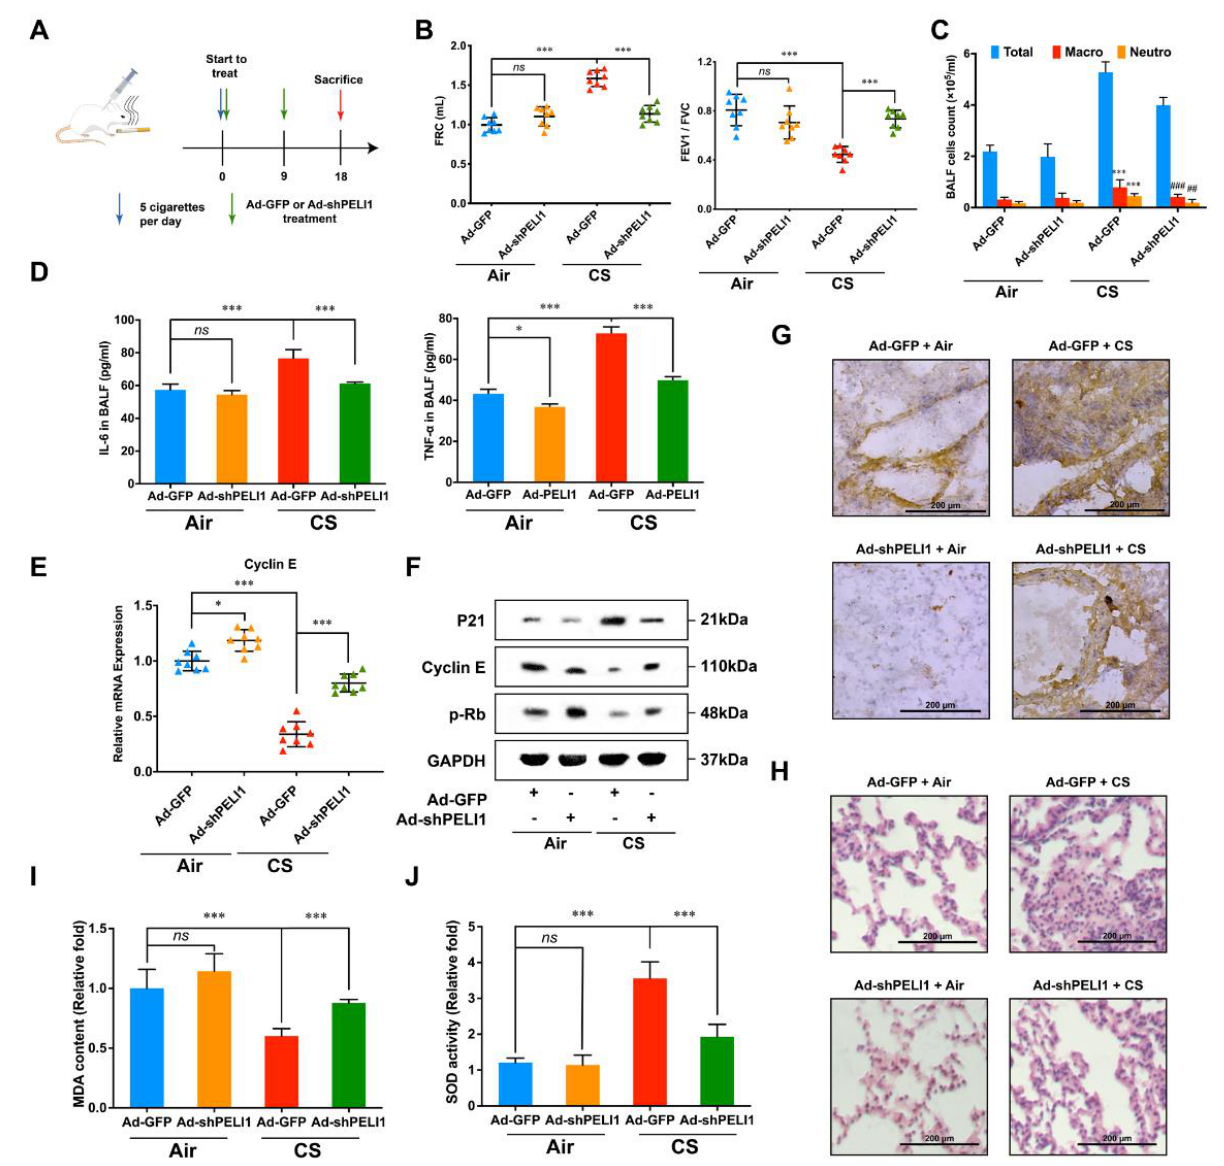
Figure 4. Silencing Pellino-1 inhibited COPD in anti-senescence and anti-inflammation pathways in vivo. ( A ) The strategy for studying the anti-COPD effects of silencing PELI1 in vivo. ( B ) FRC and FEV1/FVC following administration of 10 mg/kg budesonide 1 h before sacrifice. Silencing PELI1 decreased FRC and increased FEV1/FVC caused by CS significantly. Data represent mean ± SEM; *** p < 0.001, ns for not significant. ( C ) White cell counts in BALF showed that silencing PELI1 could decrease the high white cell counts caused by CS. Data represent mean ± SEM; ## p < 0.01, ### p < 0.001 vs. (CS + ad-GFP group), *** p < 0.001 vs. (Air + ad-GFP group). ( D ) ELISA to analyze the protein level of IL-6 and TNF- α in BALF. Silencing PELI1 significantly reduced the high protein levels caused by senescence. Data represent mean ± SEM; * p < 0.05, *** p < 0.001, ns for not significance. ( E ) Relative mRNA expression of Cyclin E was relieved by silencing PELI1. Data represent mean ± SEM; * p < 0.05, *** p < 0.001, ns for not significant. ( F ) Senescence-related protein levels were altered by silencing of PELI1. ( G ) Immunohistochemistry showed that the bronchial wall thickening caused by CS was reversed by silencing of PELI1. Protein expression of p21 was also decreased by silencing PELI1. ( H ) HE staining showed that inflammatory infiltration caused by CS in pulmonary alveoli was decreased by silencing of PELI1. ( I , J ) The change in MDA and SOD parameters caused by CS were relieved by silencing PELI1. Data represent mean ± SEM; *** p < 0.001, ns for not significant, n = 8 mice.